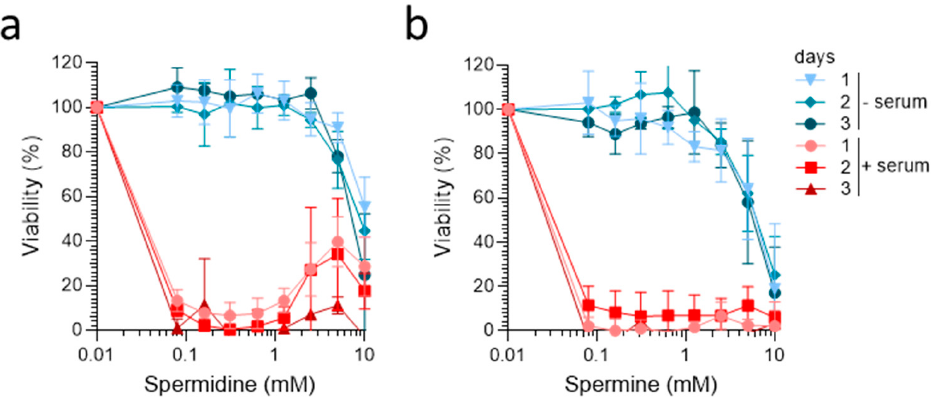
Figure 2. Spermine and spermidine are not cytotoxic under serum-free conditions. The TZM-bl cells (2 × 10 3 ) were incubated with the indicated concentrations of ( a ) spermidine and ( b ) spermine in the presence of medium with 10% FCS (+serum) or chemically defined serum-free medium ( − serum). Cell viability was determined after incubation for 1, 2, and 3 days using MTT assay. Data shown are average % values derived from three individual experiments performed in biological triplicates ± SD.